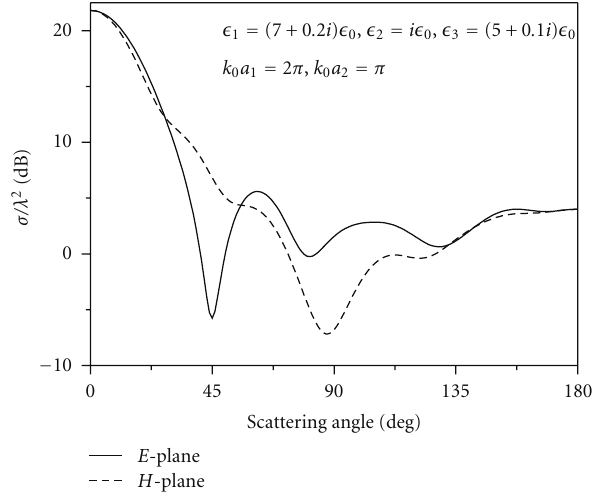
Figure 4: Radar cross-sections (RCSs) versus scattering angle θ (in degrees) in the E -plane (solid curve) and in the H -plane (dashed curve). The electric dimensions of the outer and inner spherical surfaces are chosen as k 0 a 1 = 2 π and k 0 a 2 = π while the permittivity tensor elements of the plasma are assumed to be (cid:2) 1 = (7 + 0 . 2 i ) (cid:2) 0 , (cid:2) = i (cid:2) (cid:2) = (5 + 0 . 1 i ) (cid:2) 2 0 , and 3 0 , respectively.